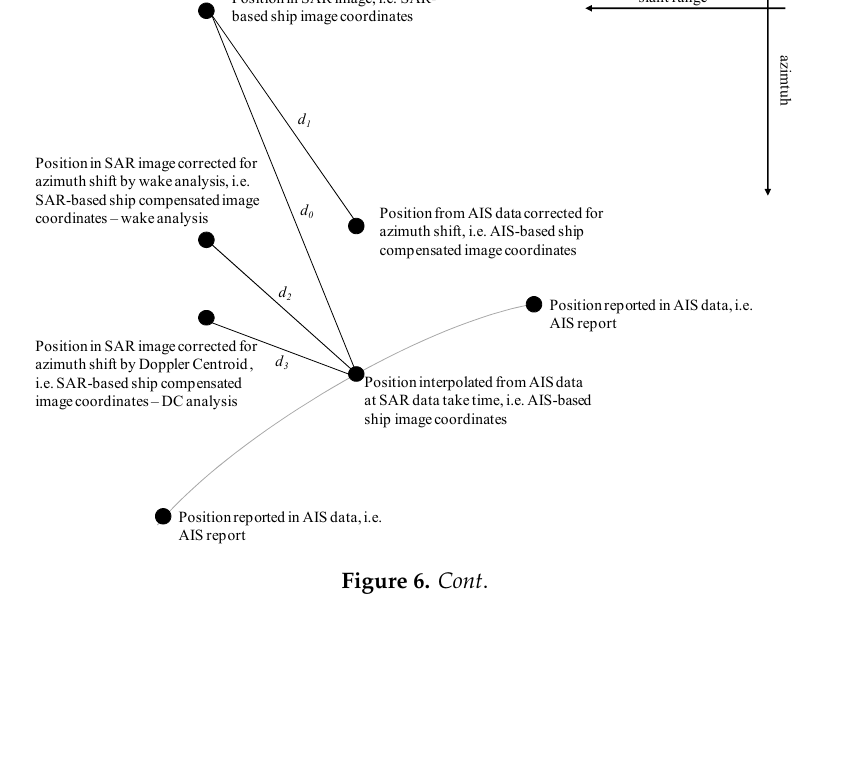
Figure 6. SAR-based and AIS-based ship positions in SAR image domain. Pictorial view of positions and distances ( top ), application example on ship of Figure 1 ( bottom ).